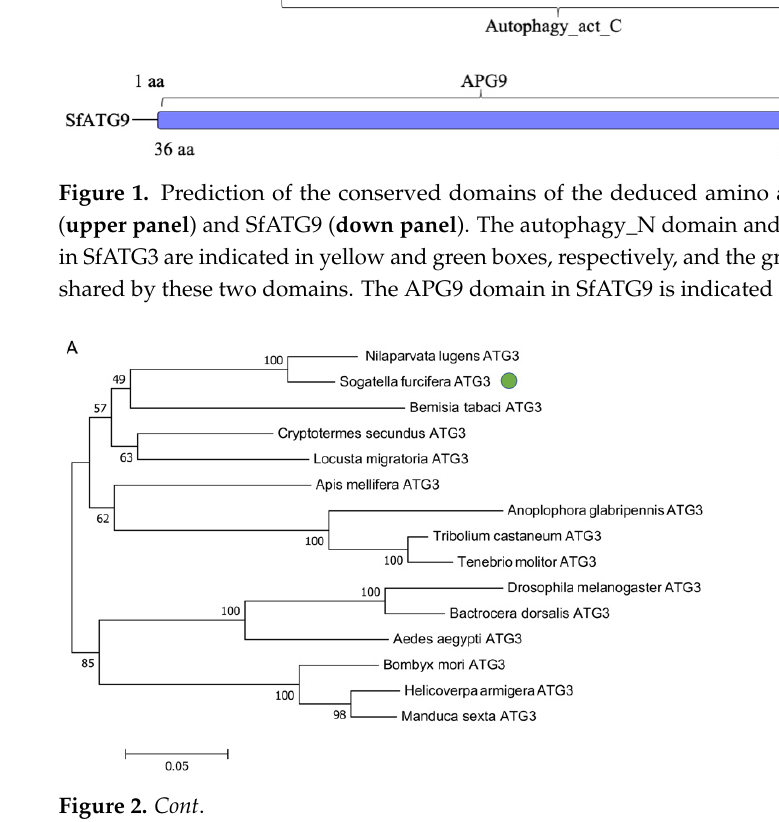
Figure 2. Phylogenetic analysis of ATG3 ( A ) and ATG9 ( B ). Multiple alignments of amino acids of ATG3 and ATG9 were performed by muscle program and the phylogenetic tree was constructed using the neighbor-joining method with a P-distance of MEGA 7.0 (5000 repetitions), respectively. 3.2. Temporal Expression of Virus Gene and Autophagy-Related Genes in SRBSDV-Exposed WBPH Females Expression of SfATG3 , SfATG9, and SRBSDV S9-1 and S10 was measured in WBPH females exposed to SRBSDV in comparison to those exposed to healthy rice plants. The expression of SRBSDV S9-1 (Figure 3A) and S10 (Figure 3B) was undetectable in virus- exposed WBPH at 0 dpe, then increased and peaked at 4 dpe and then decreased (F ≥ 58.04; df = 3,8, p < 0.001). The temporal expression of the ATG genes followed a similar pattern to that of the SRBSDV S9-1 and S10, also peaking at 4 dpe in SRBSDV-exposed WBPH females ( SfATG3 , F = 8.360, df = 4,10, p = 0.003, Figure 3C; SfATG9 , F = 8.435, df = 4,10, p = 0.003, Figure 3D). However, no significant differences in the relative expression levels of the ATG genes in the WBPH exposed to healthy rice plants were detected among different time points ( SfATG3 , F = 2.691, df = 4,10, p = 0.093, Figure 3C; SfATG9 , F = 3.684, df = 4,10, p = 0.596, Figure 3D). Expression levels of SfATG3 and SfATG9 were significantly higher at 4 dpe and, of SfATG3 at 8 dpe, in the females exposed to SRBSDV-infected plants (Sf-V) than those to healthy plants (Control) ( t -test, p < 0.05, Figure 3C,D).